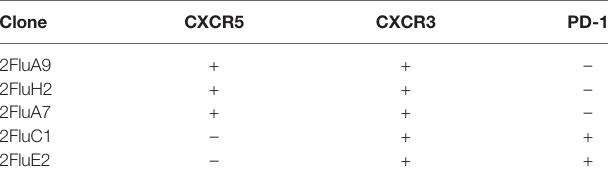
TABLE 3 | Index-sorting phenotype of Flu clones.